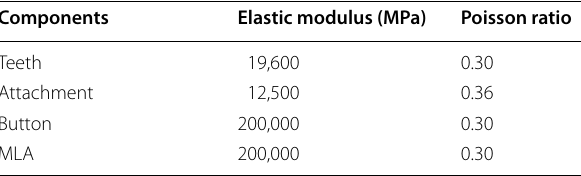
Table 2 Material properties of the components in the FE models